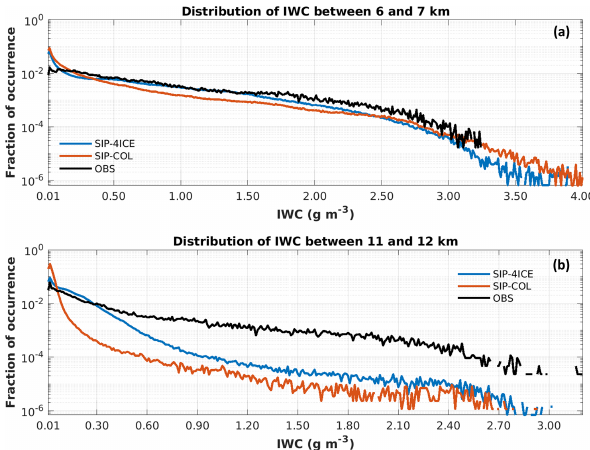
Figure 21. Similar to Fig. 9 but for SIP-4ICE and SIP-COL.